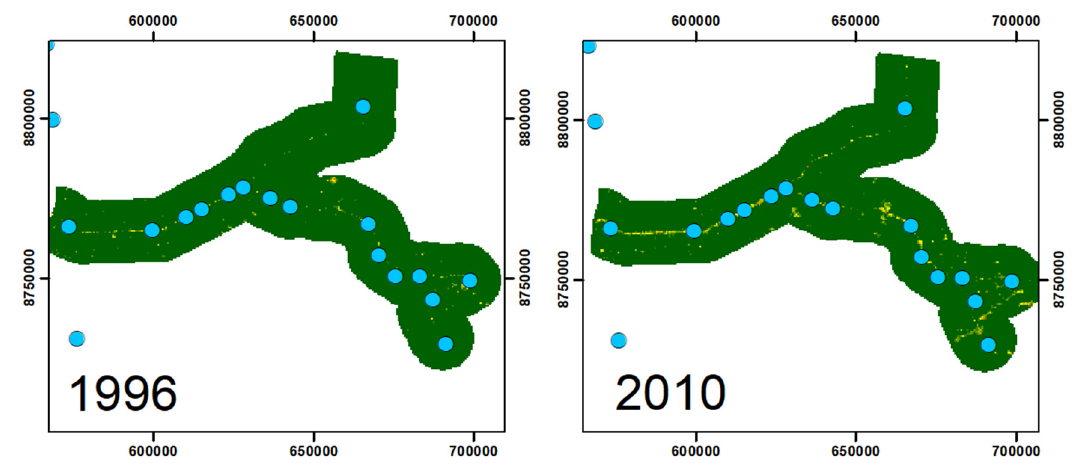
Figure 8. Spatial depiction of the deforestation probabilities predicted by the random forest model fitted using case-control (CC) data. Top panels display deforestation predictions for the road segment that was paved after 2005 while the bottom panels display predictions for the unpaved road segment. Left and right panels display predictions for 1996 and 2010, respectively. Tick marks show the WGS84 UTM Zone 19S projected coordinates. Deforestation probabilities are shown with the background heat map.